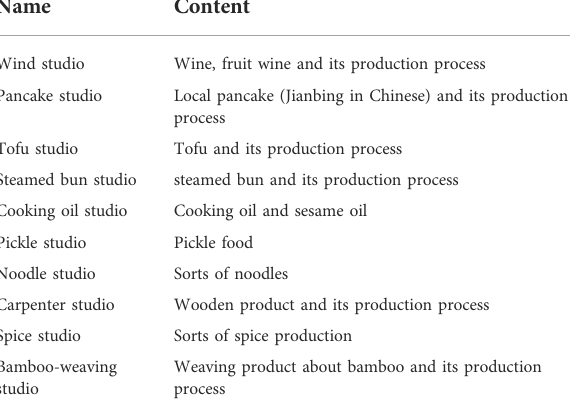
TABLE 4 The category of Hundred Craft Studio in Yayou Gou